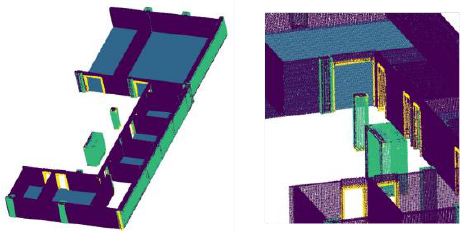
Figure 8. a) the result of the semantic segmentation, among a great majority of correctly labelled points, a façade wall is misclassified as a long beam; b) a close-up to the results, the door frames are recognized well.